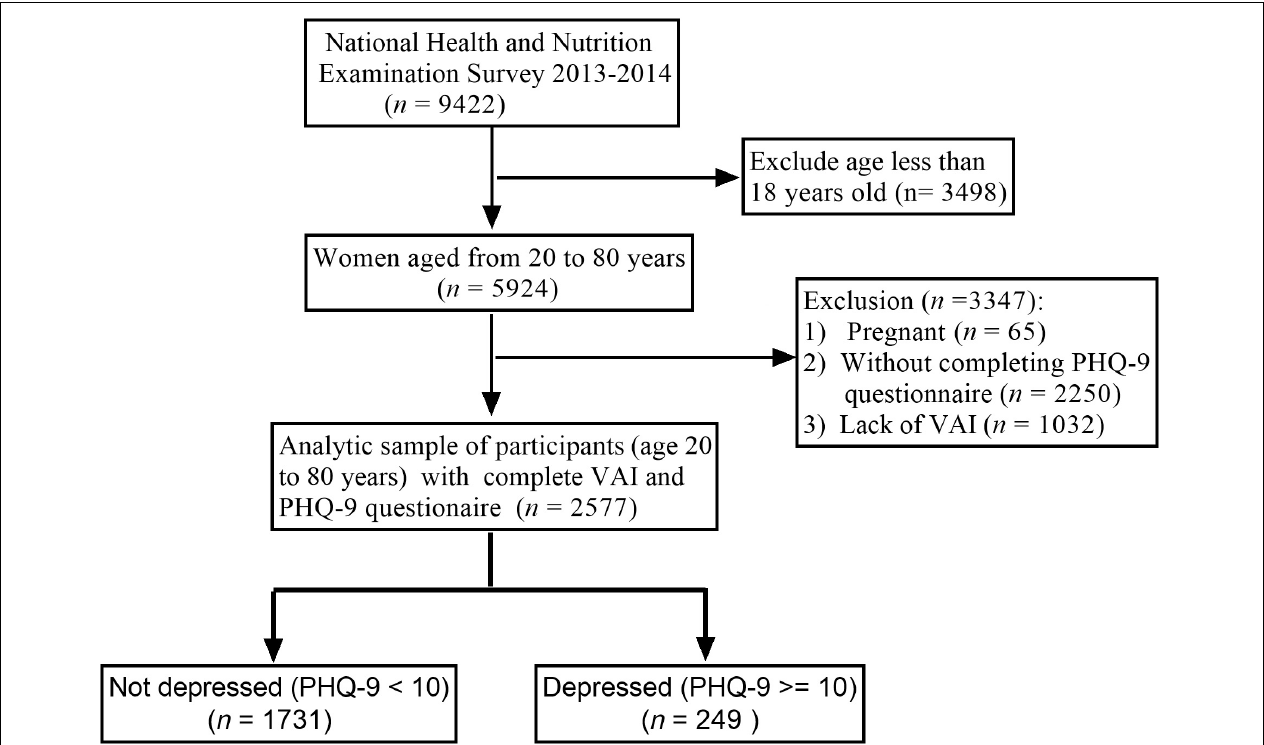
FIGURE 1 | Flowchart of the sample selection from NHANES